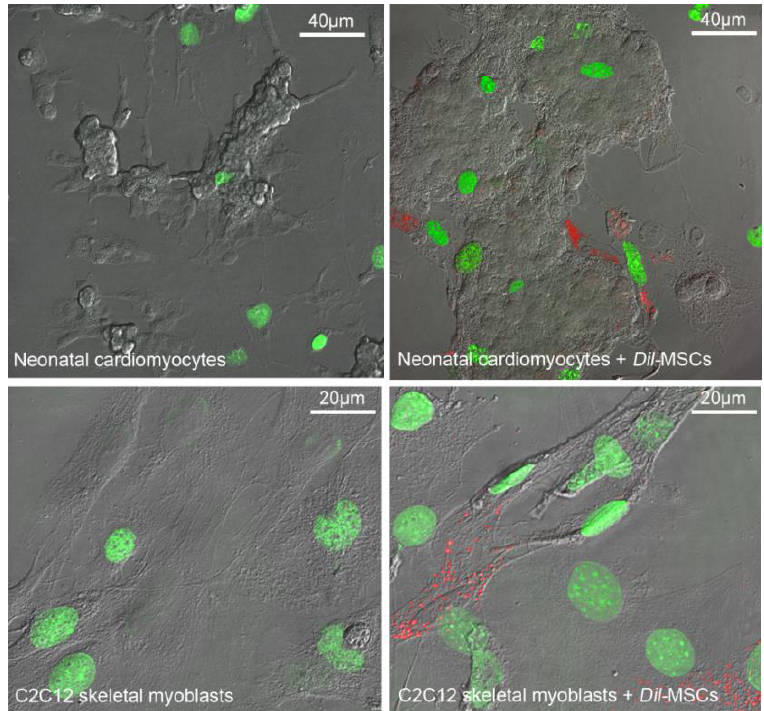
Figure 1. Bone marrow-derived mesenchymal stromal cells (BM-MSCs) stimulate proliferation of muscle progenitor cells. Representative superimposed differential interference contrast (DIC) and confocal fluorescence images showing the pyrimidine analogue EdU (5-ethynyl-2'-deoxyuridine) staining (green) in the nuclei of proliferating murine C2C12 skeletal myoblasts or murine neonatal cardiomyocytes in single and co-culture for 24 h with mouse Dil-labeled BM-MSCs (red). Note the higher number of proliferating cells in the co-culture